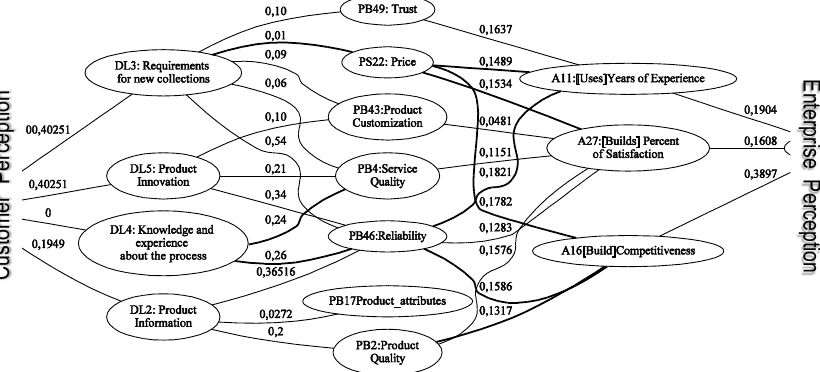
Fig. 8. The integration of Pontechem and Customer